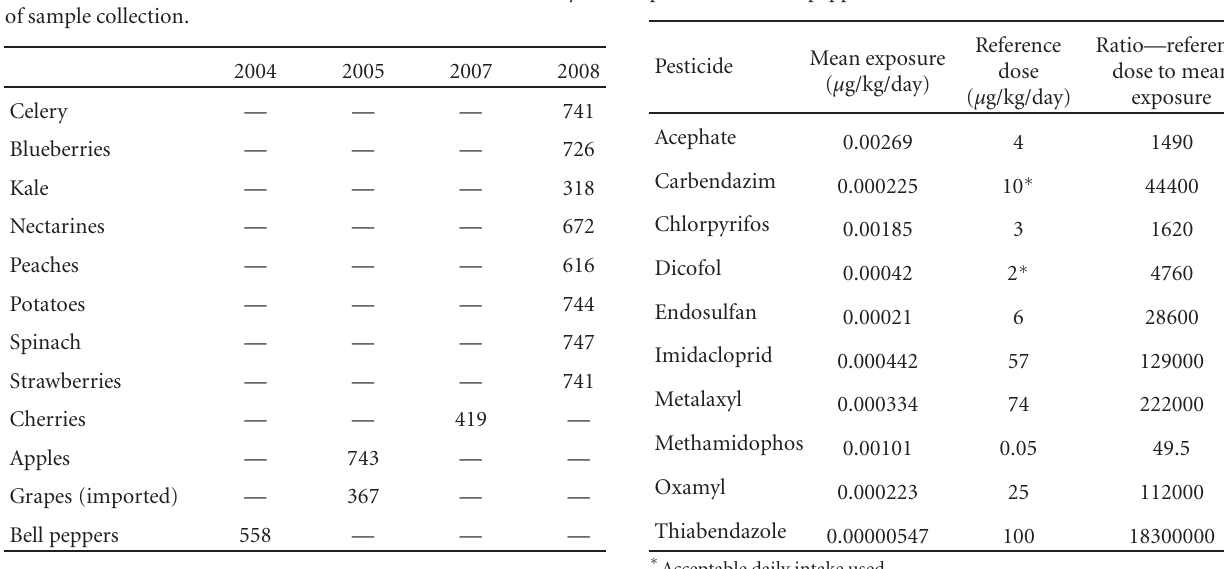
Table 3: Exposure estimates of the ten most frequently detected pesticides on bell peppers.